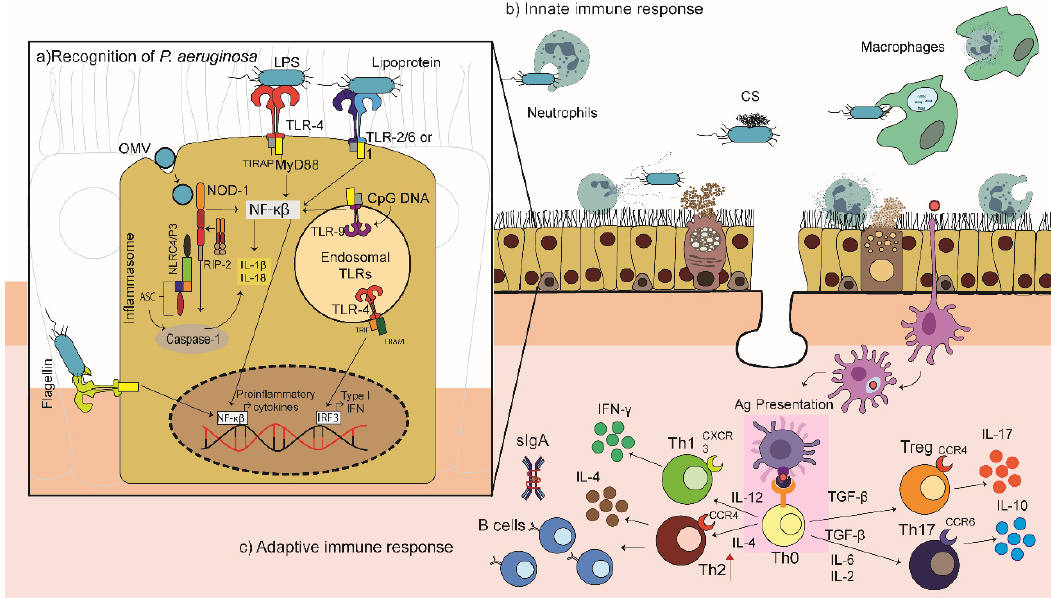
Figure 2. Host immune response against P. aeruginosa infections in the pseudostratified respiratory epithelium. ( a ) Recognition of P. aeruginosa . Pathogen recognition receptors (PRRs) located on the immune cells (TLR2, TLR4, TLR5, TLR9) recognise the PAMPs of P. aeruginosa (Lipoprotein, LPS, flagellin, and CpG-DNA, respectively) and trigger the production of pro-inflammatory cytokines and chemokines. OMV endocytosis activates the NF- κ B pathway. ( b ) Innate immune response. (i) Neutrophils, recruited in response to P. aeruginosa (ii) Macrophages, which phagocytise bacteria or dying neutrophils (iii) complement system (CS). ( c ) Adaptive immune response. A skewed Th2 response occurs during P. aeruginosa infection with high but inefficient antibody production. In addition, the production of sIgA seems to be relevant, as its levels may correlate with the status of Pseudomonas infection.